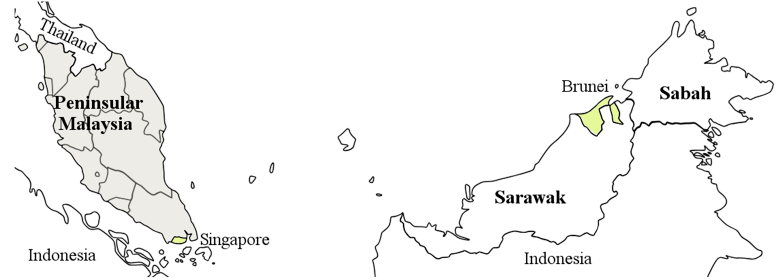
Figure 2. Study site: Peninsular Malaysia and its position relative to East Malaysia.